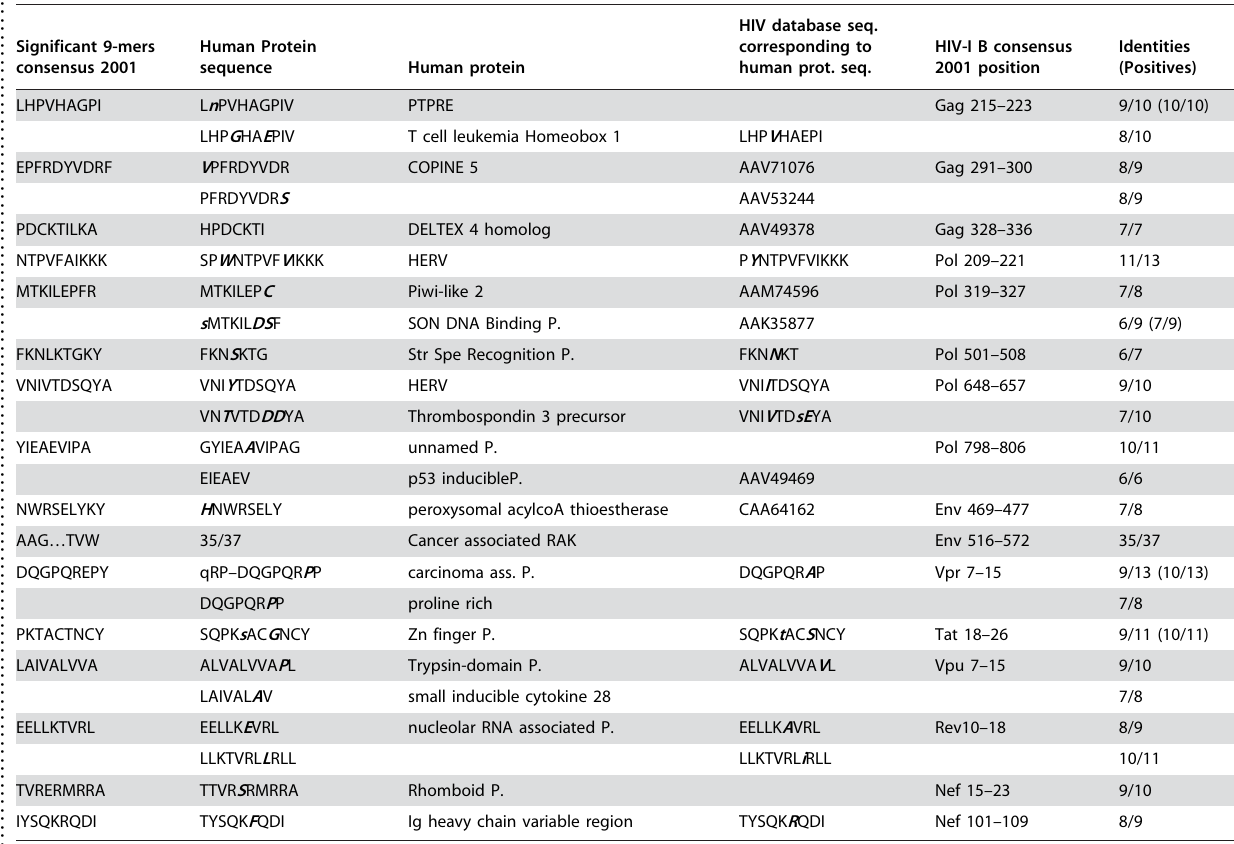
Table 1. HIV-1 nonamers with high similarities to human proteins. .. ... .... ... ... .... ... ... .... ... ... .... ... ... .... ... ... .... ... ... .... ... ... .... ... ... .... ... ... .... ... ... .... ... ... .... ... ... .... ... ... .... ... ... .